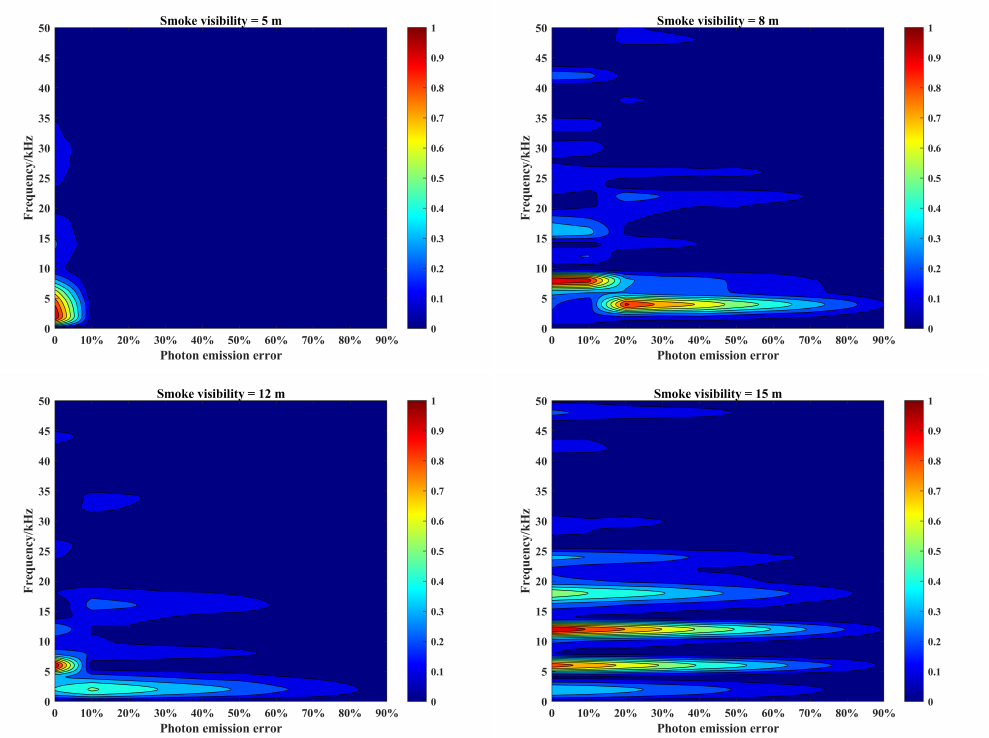
Figure 11. Amplitude–frequency characteristics of beat signals corresponding to photon emission errors of laser source under different smoke visibility